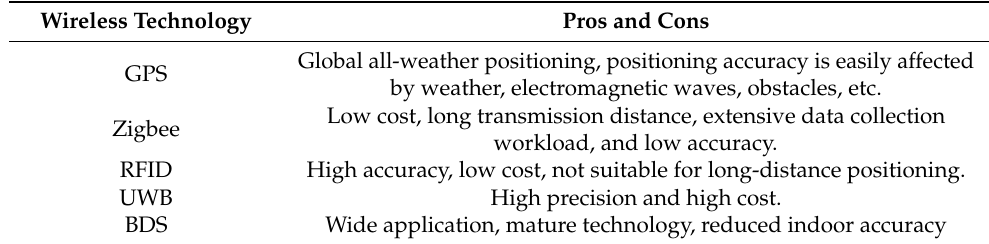
Table 1. Comparison of several wireless technologies. Wireless Technology Pros and Cons Global all-weather positioning, positioning accuracy is easily affected GPS by weather, electromagnetic waves, obstacles, etc. Low cost, long transmission distance, extensive data collection Zigbee workload, and low accuracy. RFID UWB